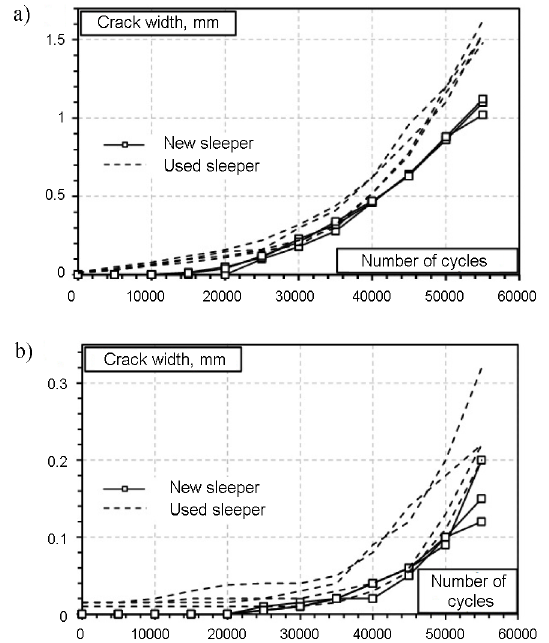
Fig. 7. w - N relationships: a) crack width under dynamic load; b) residual crack width